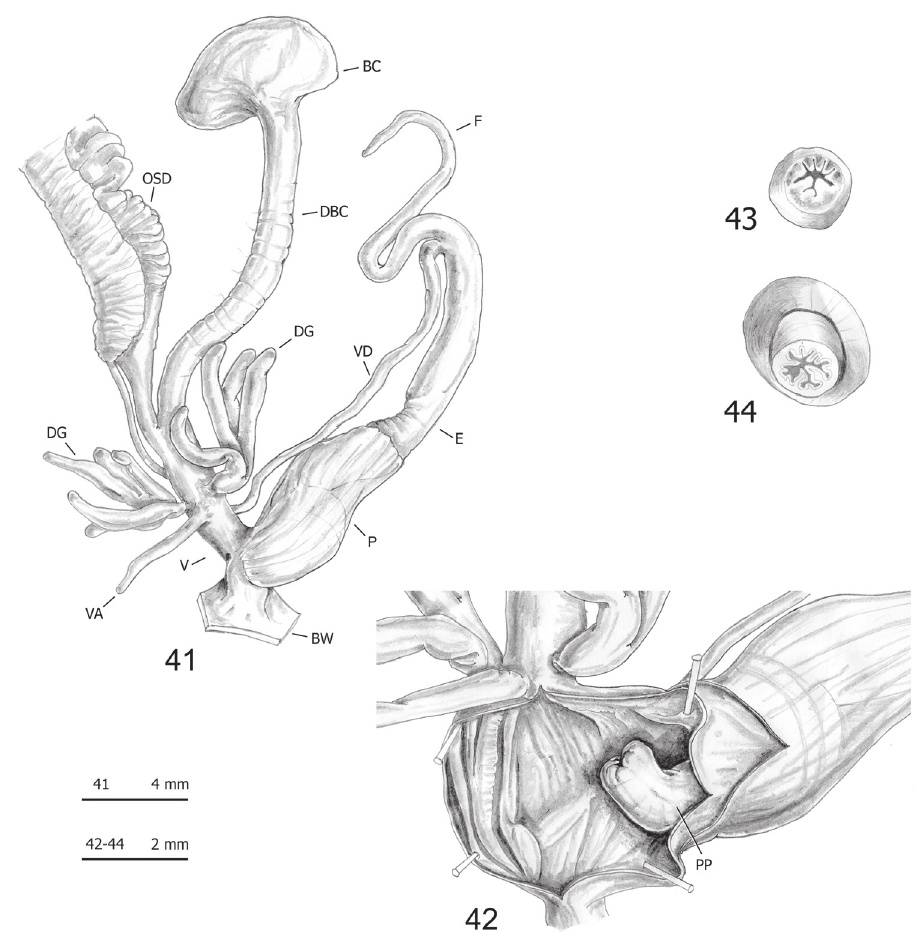
Figures 41–44. Genitalia (proximal parts excluded) ( 41 ), internal structure of distal genitalia ( 42 ), transverse sections of medial epiphallus ( 43 ) and apical penial papilla ( 44 ) of Monacha pantanellii from Monte Fionchi, Torrecola [Fio2] (FGC